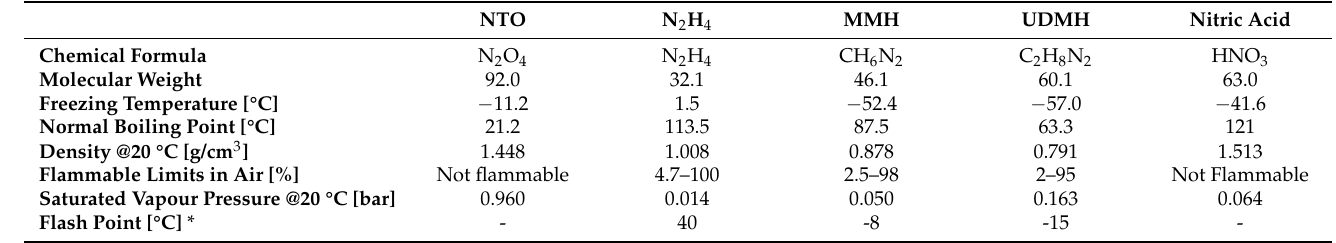
Table 2. Properties of hydrazines, NTO and nitric acid. Data retrieved from Refs. [38,43,57,58]. NTO N 2 H 4 MMH UDMH Chemical